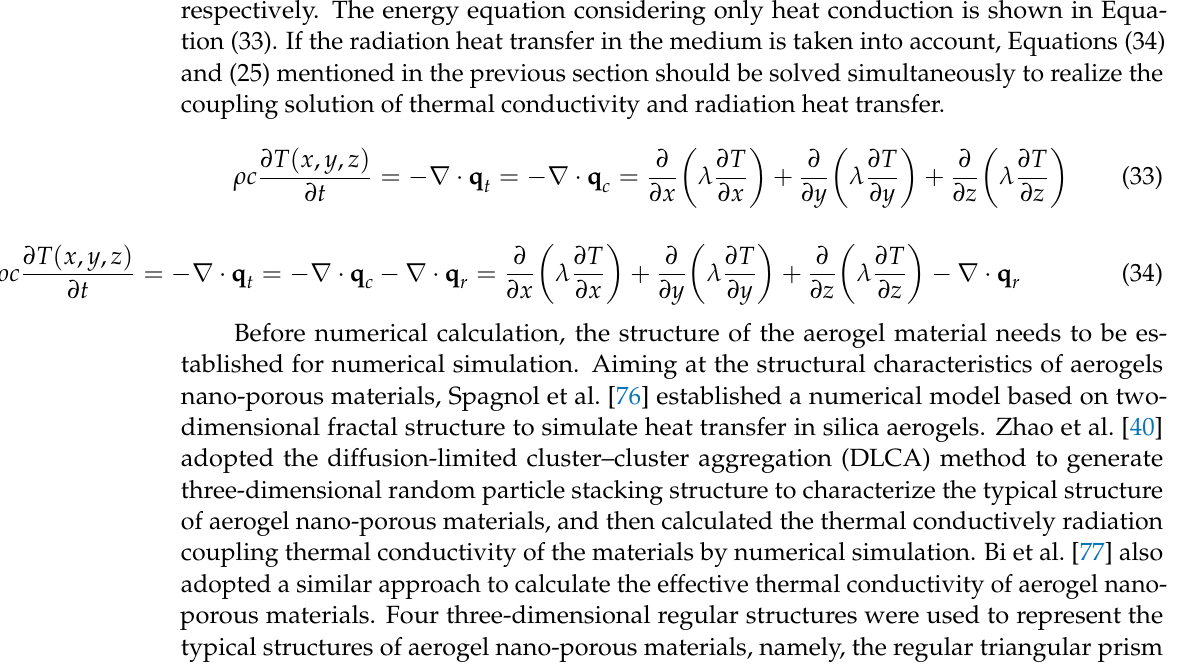
Figure 17. Regular geometric structure: ( a ) Cubic packing structure; ( b ) The face-centered cubic packing structure; ( c ) The cubic array of intersecting spheres.